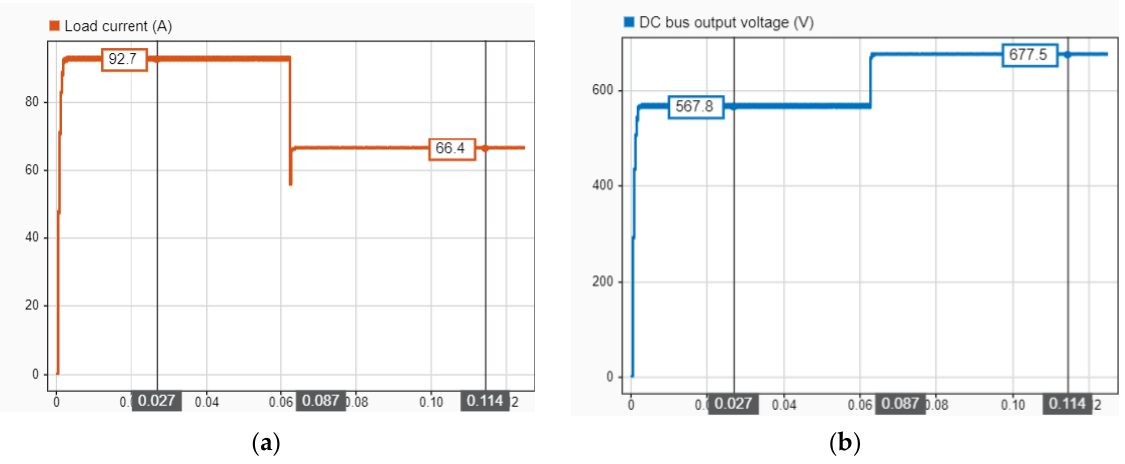
Figure 14. Load current and output voltage for a variation of the power load from 80 kW to 70 kW: